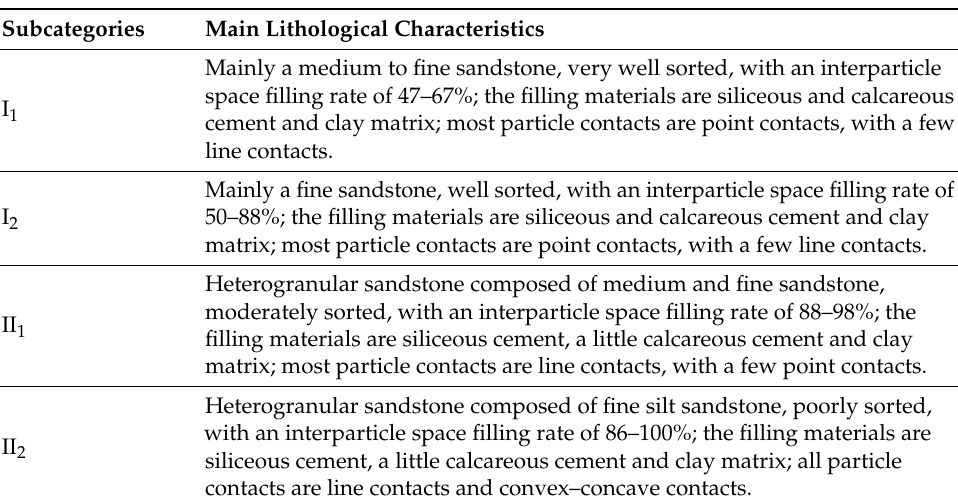
Table A5. Lithological characteristics of different sandstone